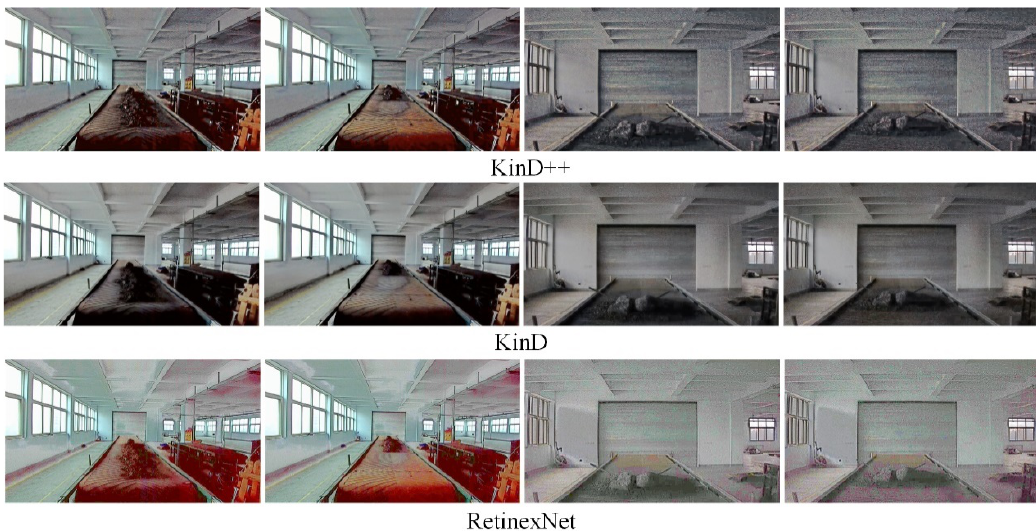
Figure 13. Deep learning algorithm for enhancement of evening images without light source.